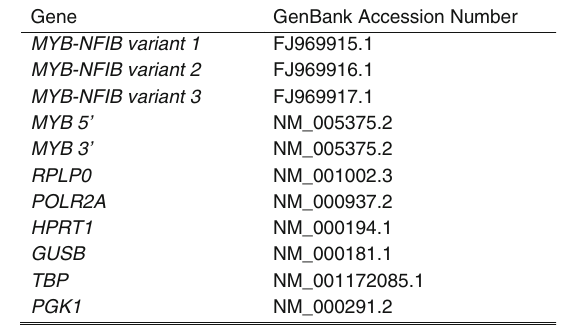
Table 2 Nanostring codeset gene